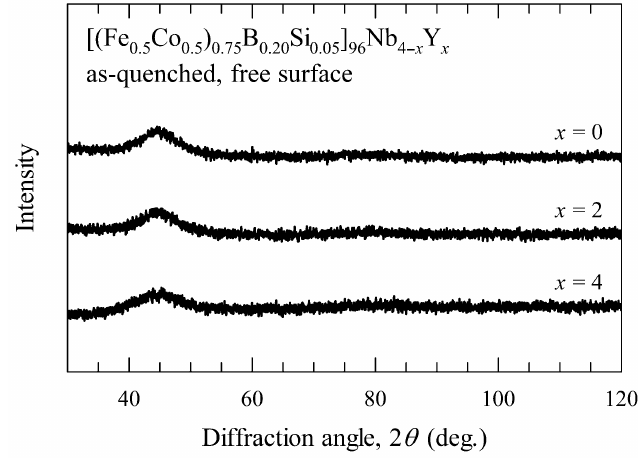
Figure 1. X-ray diffraction profiles of [(Fe 0.5 Co 0.5 ) 0.75 B 0.20 Si 0.05 ] 96 Nb 4− x Y x alloys taken from free surface in an as-quenched state.